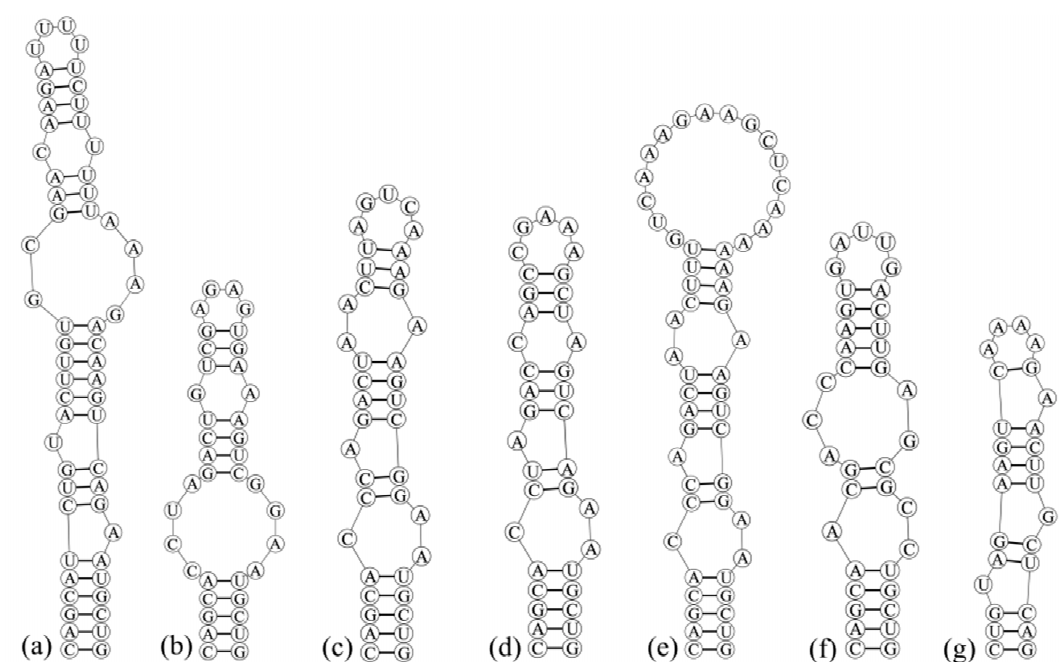
Figure 4. D1–D1 ′ helix in Microcoleusiopsis ganfuensis and other six related species. ( a ). Microcoleusiopsis ganfuensis CHAB 4138. ( b ). Microcoleus pseudautumnalis AK1609. ( c ). Microcoleus vaginatus CSU-U-KK1. ( d ). Microcoleus vaginatus PTRS-2. ( e ).